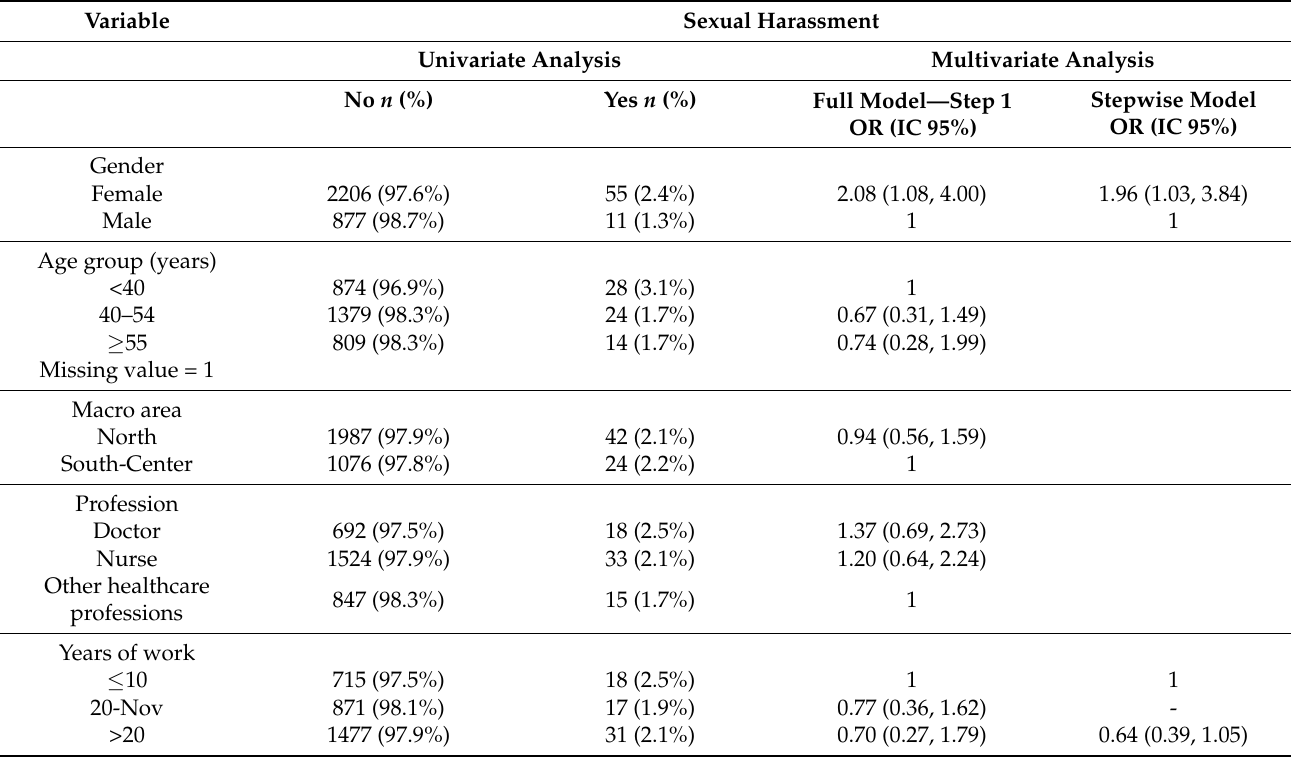
Table 3. Being a victim of sexual harassment: univariate and multivariate analysis.